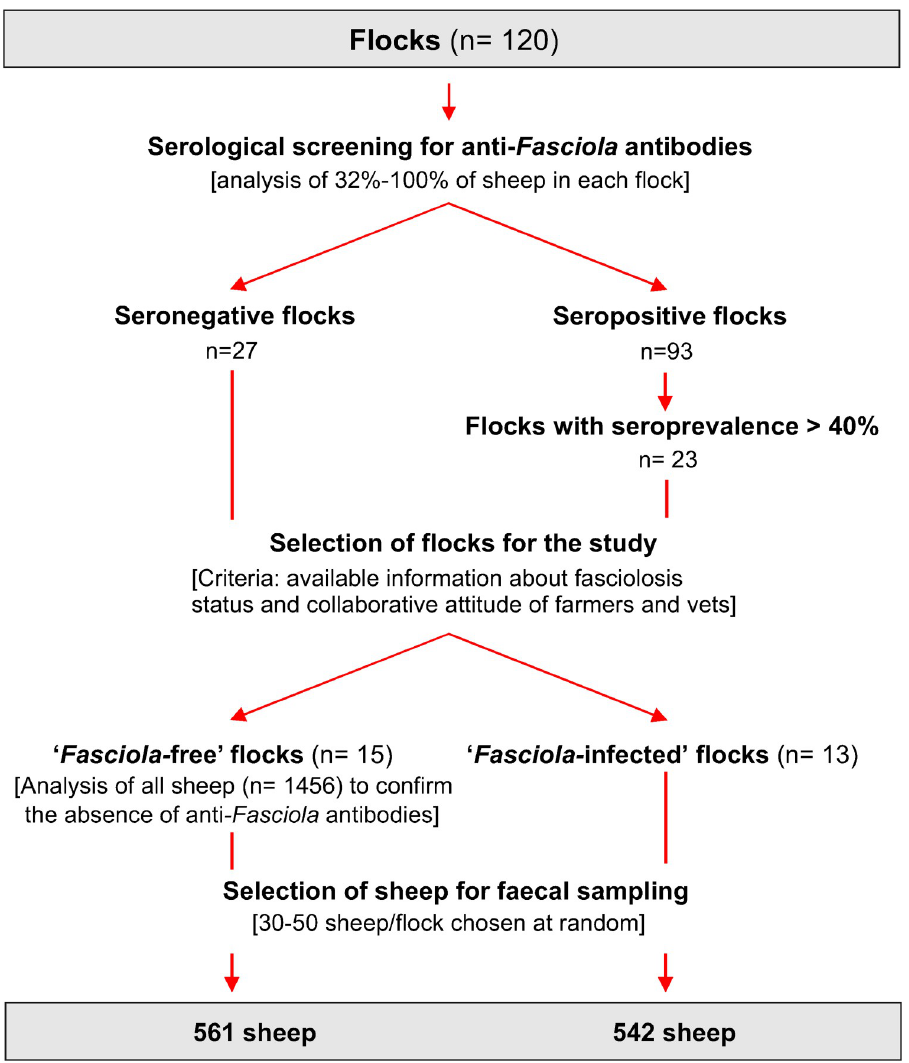
Fig 1. Diagram showing the process of selection of the 1103 sheep tested in the